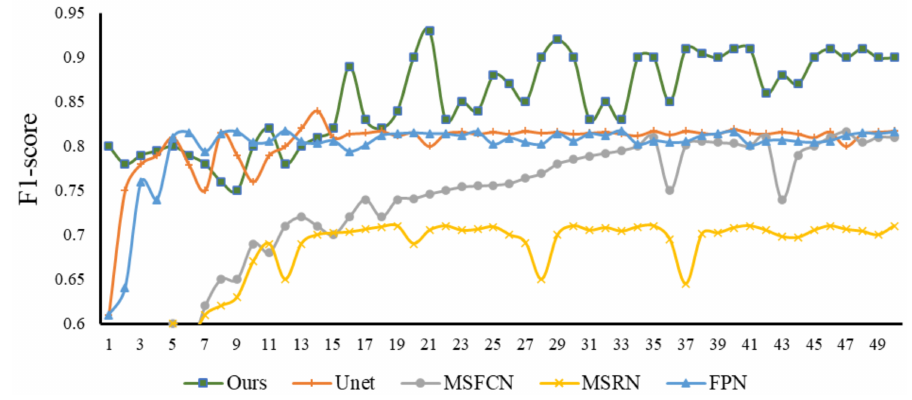
Figure 14. F1-score changes of each